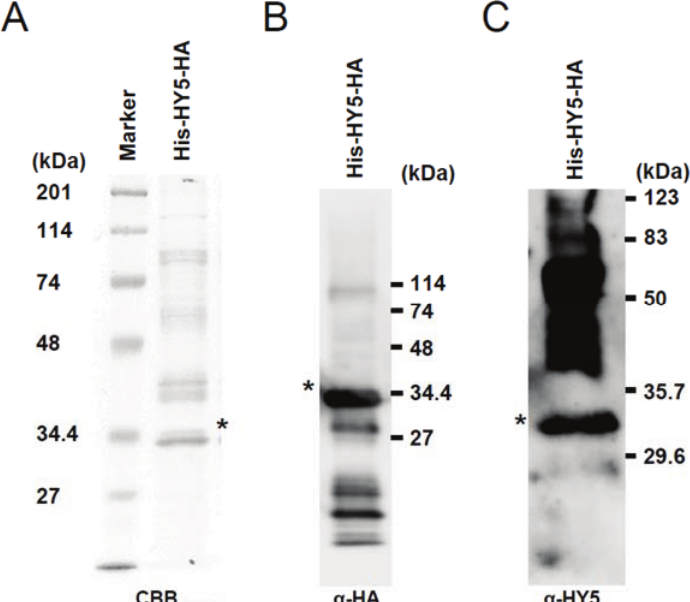
Figure 1. Recombinant His-HY5-HA protein produced in wheat embryo extract. ( A ) CBB (Coomassie Brilliant Blue) staining of the gel on which purified proteins were loaded. ( B ) and ( C ) Western blot analysis of the purified proteins using anti-HA antibody ( B ) and anti-HY5 antiserum ( C ), respectively. Asterisks indicate the positions of His-HY5-HA,